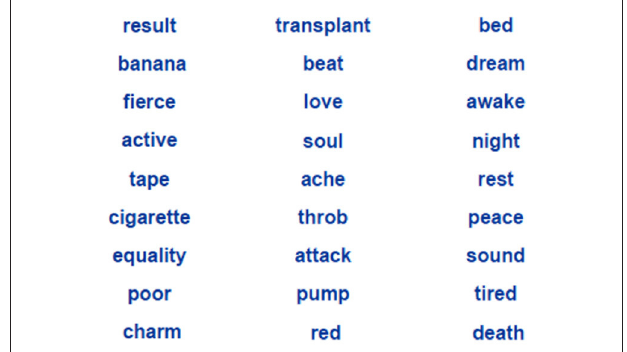
FIGURE 1 | Three examples of items presented as micropoems in this study. Items are ordered according to their semantic cohesion (in parenthesis), from left to right: Match 4 (0.208), EAT 3 (0.264), EAT 5 (0.369). For a comprehensive overview over the items please cf. Table 1 ; Supplementary Tables 1, 2